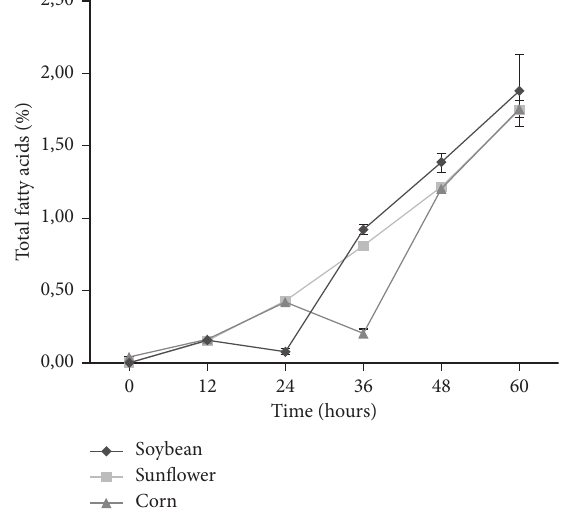
Figure 4: Occurrence of trans-fatty acids during the heating process from 0 hours (fresh oil) to 60 hours at 240 ° C of soybean, sunflower, and corn